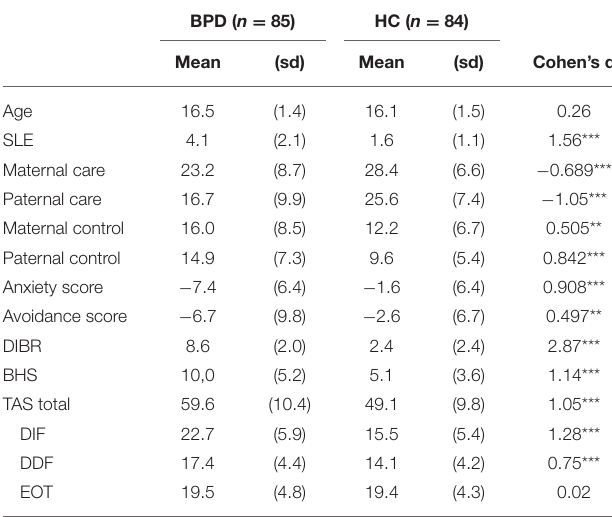
TABLE 1 | Comparison between BPD and HC groups on parental bonding, stressful life events, attachment, affective symptoms, hopelessness, and